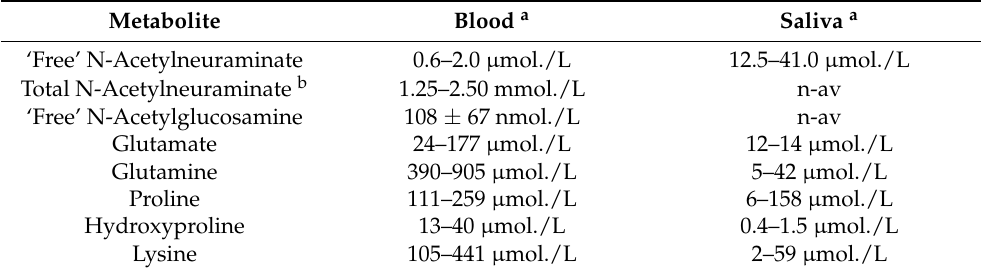
Table 2. Scientific literature mean concentrations of biomolecules with 1 H NMR resonances located in or close to the APP (1.96–2.10 ppm) regions of high-resolution spectra of human blood and saliva (Figure 4). a Ranges of mean values obtained from healthy control data were obtained from the Human Metabolome Database [101]. b Total N-acetylneuraminate level, including both APP and low-molecular-mass forms. Abbreviations: n-av, data not available. Metabolite Blood a Saliva a ‘Free’ N-Acetylneuraminate 0.6–2.0 µ mol./L 12.5–41.0 µ mol./L Total N-Acetylneuraminate b 1.25–2.50 mmol./L n-av ‘Free’ N-Acetylglucosamine 108 ± 67 nmol./L n-av Glutamate 24–177 µ mol./L 12–14 µ mol./L Glutamine 390–905 µ mol./L 5–42 µ mol./L Proline 111–259 µ mol./L 6–158 µ mol./L Hydroxyproline 13–40 µ mol./L 0.4–1.5 µ mol./L Lysine 105–441 µ mol./L 2–59 µ